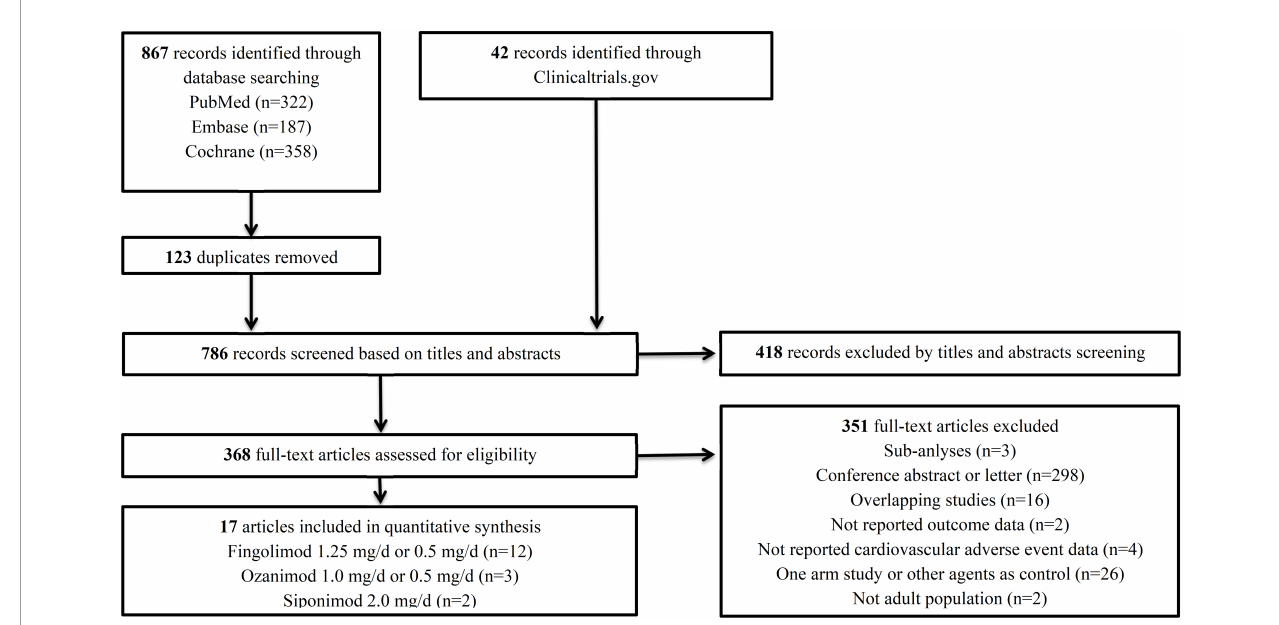
FIGURE 1 | Flow diagram for the selection of eligible